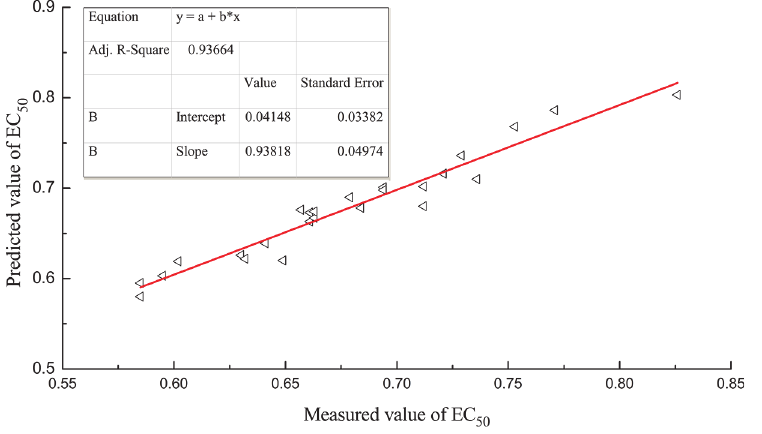
Fig 6. Correlation between the predicted and measured EC 50 values for CBAT